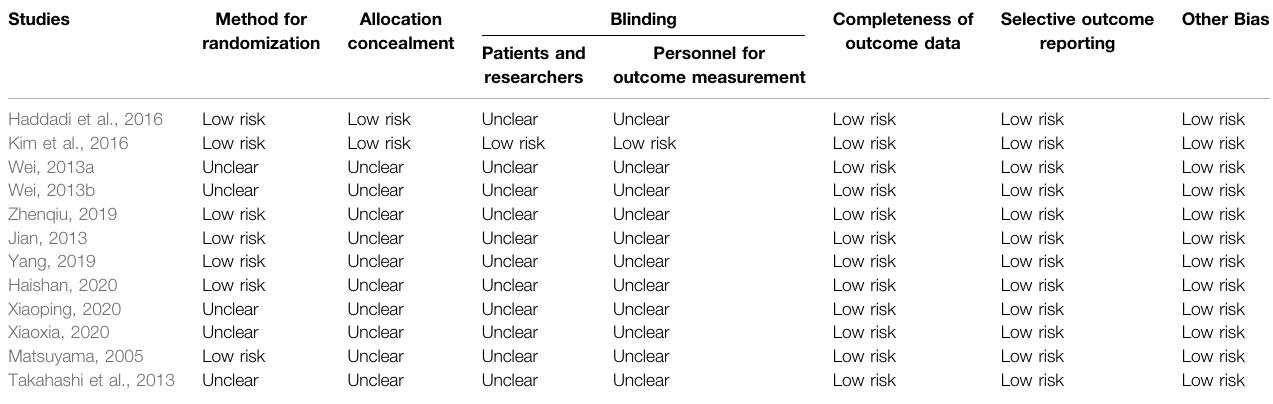
TABLE 2 | Bias assessment of included